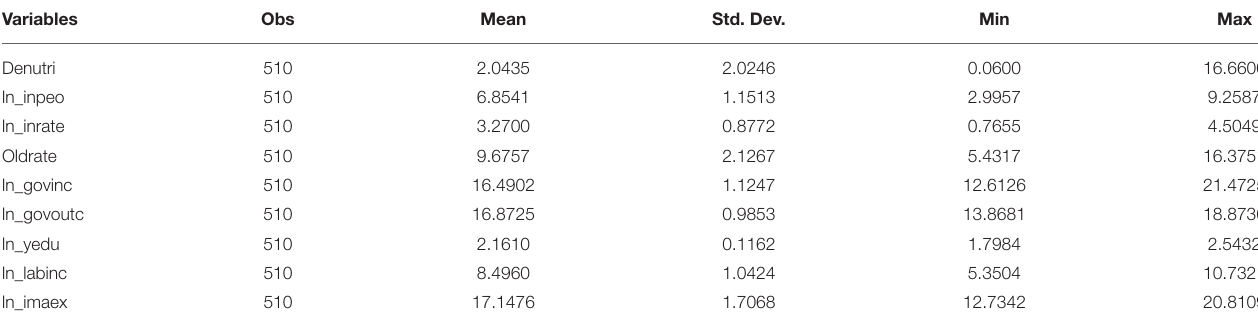
TABLE 1 | Descriptive statistics of the variables.